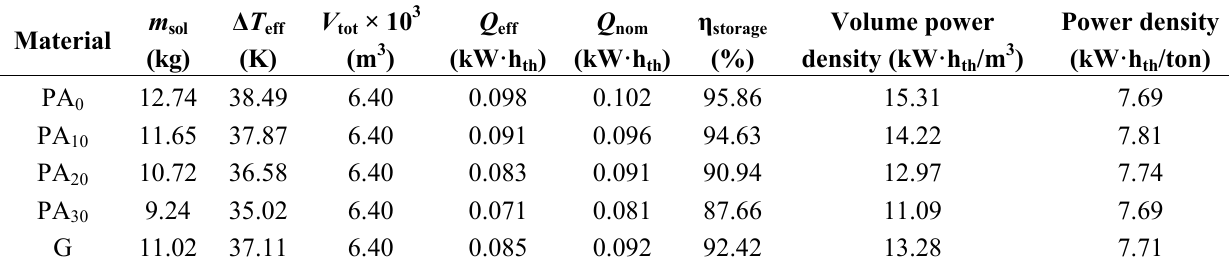
for developed tot